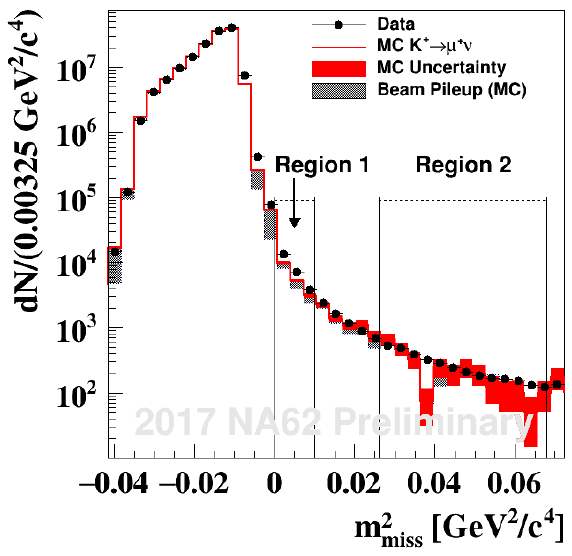
Figure 5. Distribution of m 2